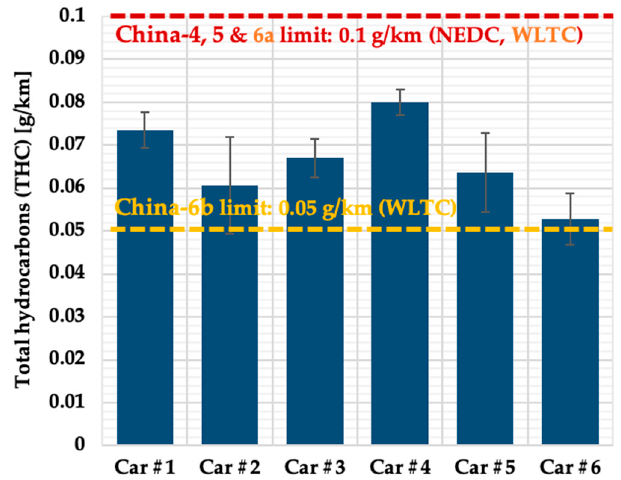
Figure 4. Total hydrocarbons (THC) emissions from the in-use methanol taxis.